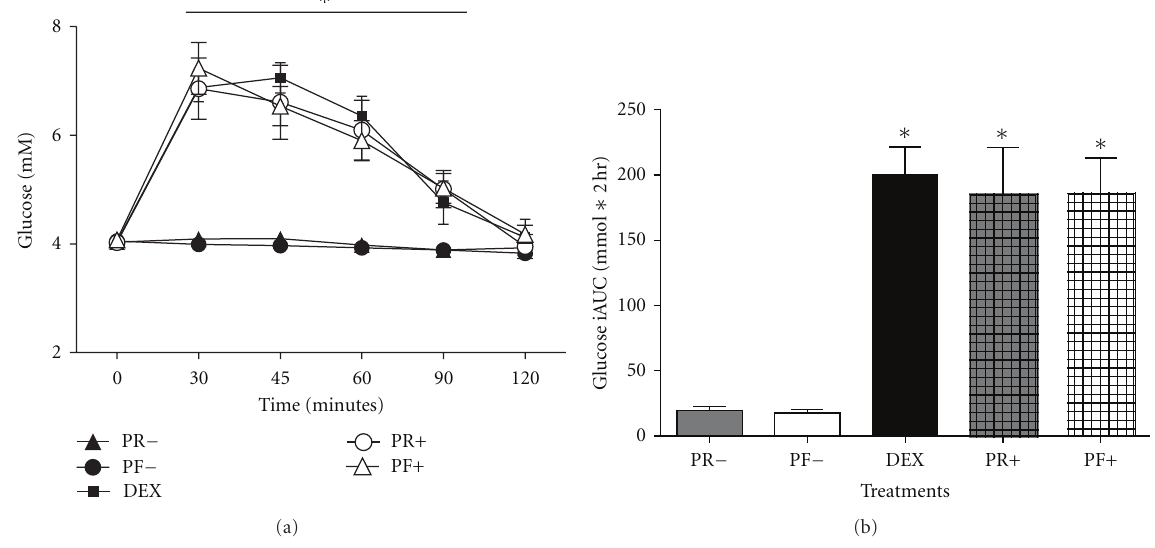
Figure 1: (a) The glucose responses to 38g of resistant starches with water only (PR − and PF − ), with 50 g of dextrose (PR+ and PF+), and 50g of dextrose only (DEX). ∗ = P < 0 . 05 for di ff erences between PF − and PR − compared with DEX, PF+, and PR+, from 30 minutes to 90 minutes, means ± SD. (b) The iAUC values for each treatment. ∗ = di ff erent ( P < 0 . 0001) from PF − and PR − , means ± SEM.